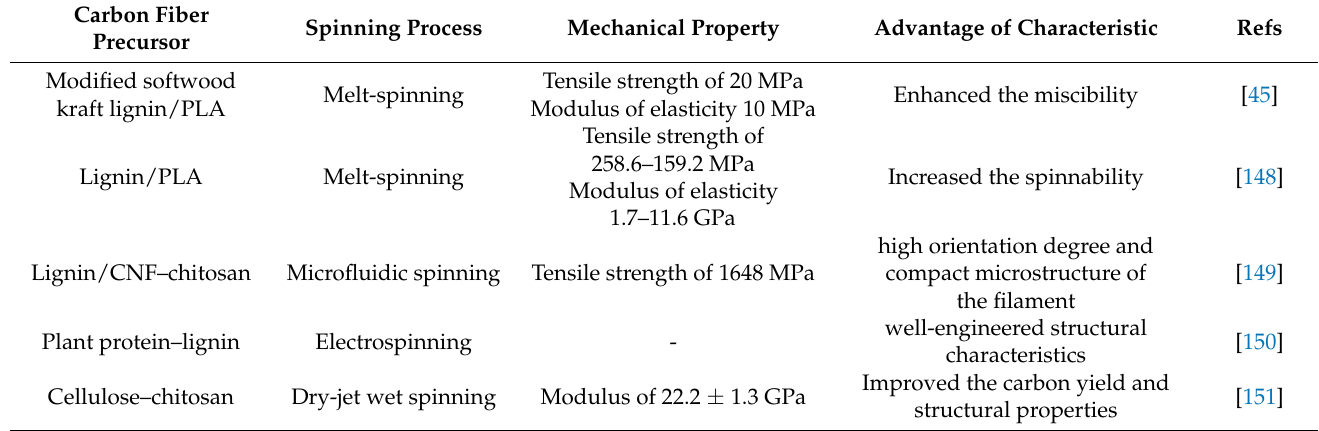
Table 2. Production and properties of CFs from composites containing various